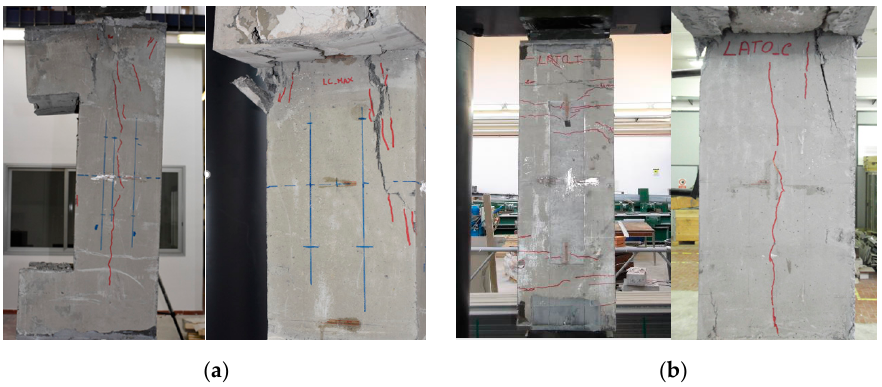
Figure 9. General views (back or lateral) and details of the final damage states for the specimen S2 ( a ) and S3 ( b ).